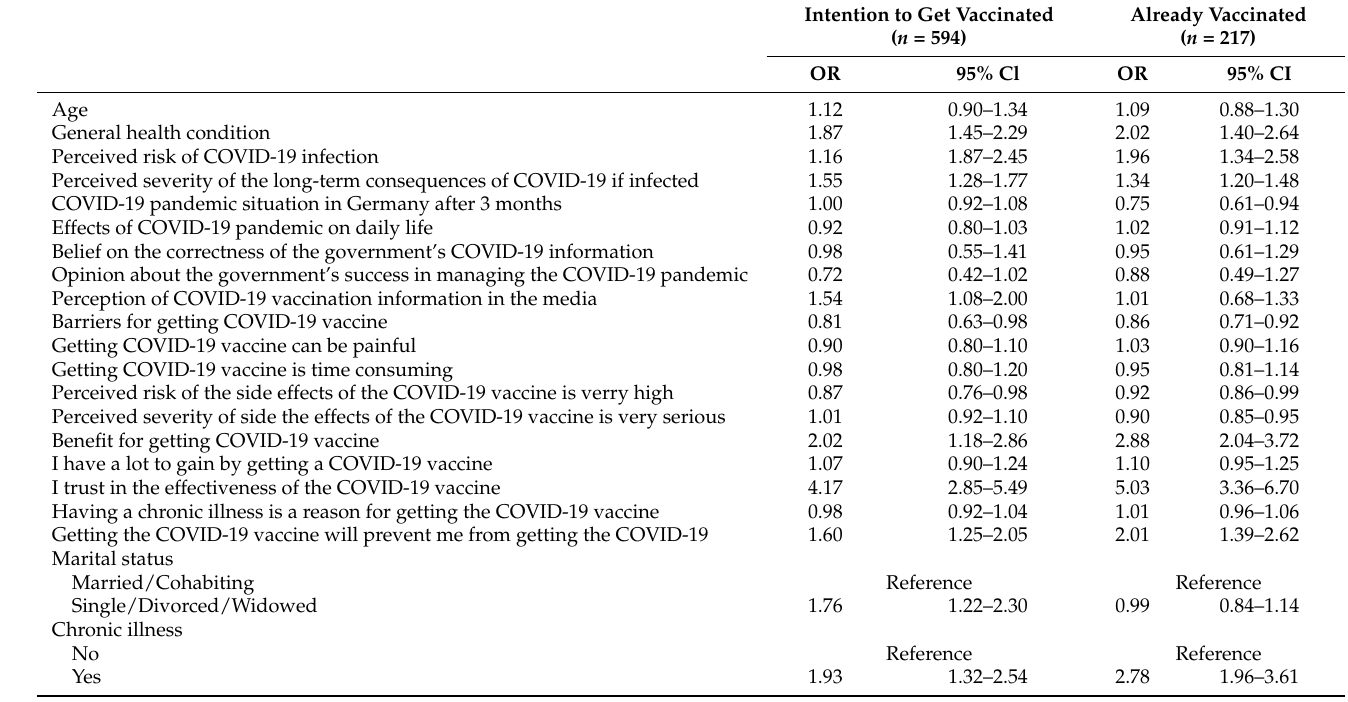
Table 3. Factors associated with the intention to get vaccinated; multinominal logistic regression analysis results for the intention to get vaccinated and already having been